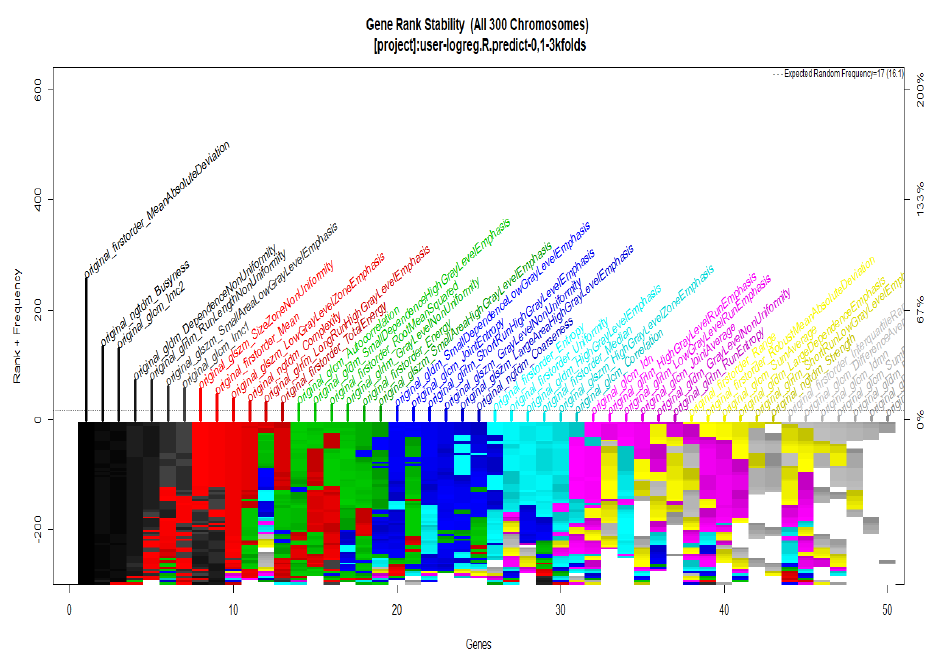
Figure 10. Gene Rank Stability graph with calcification model by radiologist segmentation; the gene rank shows the stability of the top-ranked 50 variables. The horizontal axis shows the genes ordered by rank, and the vertical axis shows the gene frequency. The bottom color—coded rank represents the genetic stability where features with no change in the color represent a stable feature; changing color features represent unstable features (i.e., not always contributing to the